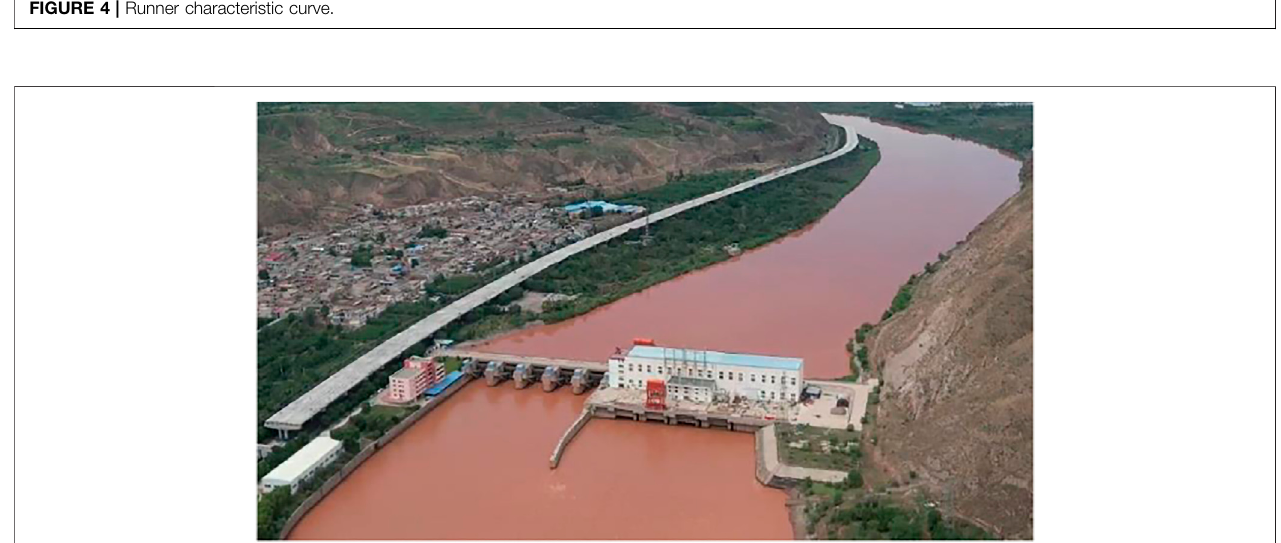
FIGURE 4 | Runner characteristic curve.